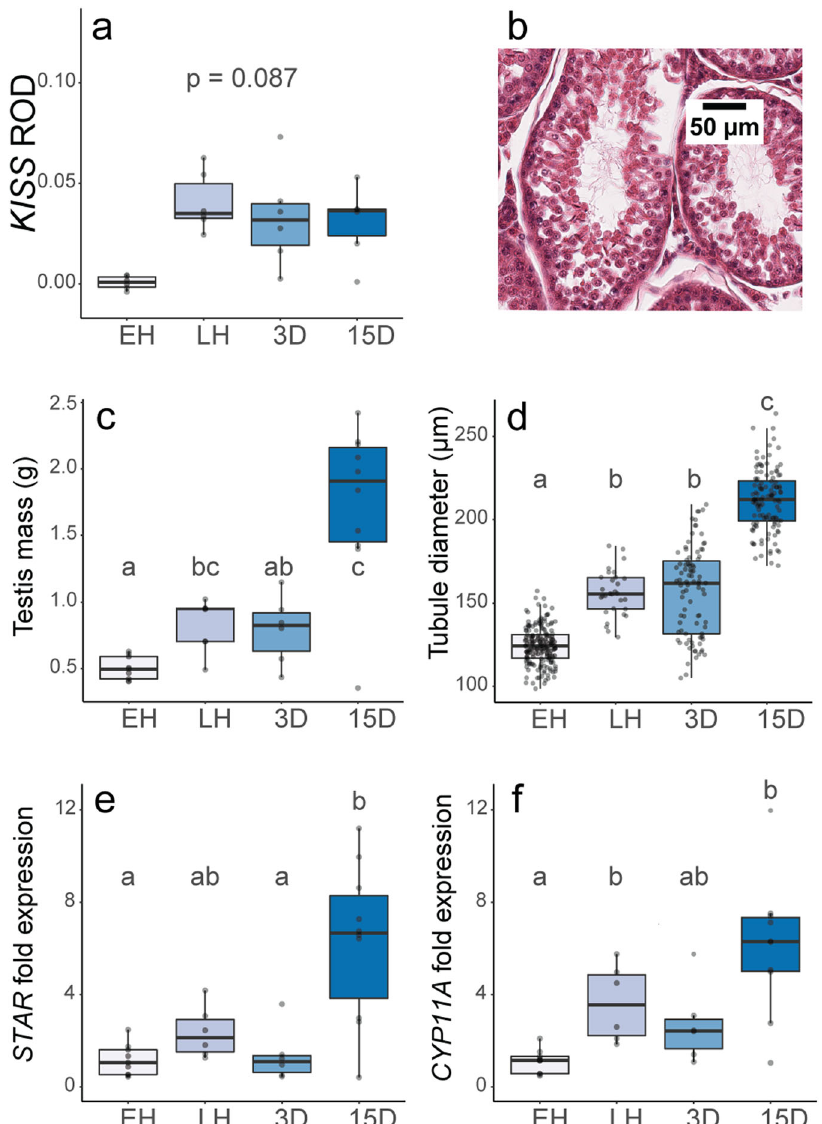
Fig. 5 Activation of reproductive axis during hibernation in male arctic ground squirrels. a Kisspeptin expression in the arcuate nucleus as quanti fi ed by in-situ hybridization (ROD = relative optical density). b Seminiferous tubule of 15D post-hibernation male arctic ground squirrel illustrating extrusion of cytosol from spermatids. c Mass of frozen testes and d diameter of seminiferous tubules in preserved testicular tissue from male arctic ground squirrels. Changes in the expression of steroidogenic genes e STAR and f CYP11A relative to early hibernation time points as quanti fi ed by qPCR of testicular tissue from male arctic ground squirrels. In all graphs, colored shading of boxplots represents distinct sampling groups, lower-case letters indicate signi fi cantly different comparisons from data analyzed with a linear mixed effects model ( p < 0.05), The center line in the box plot represents the median, box boundaries represent the 25th and 75th percentiles, and error bars of boxplots represent the 25th and 75th percentiles ± 1.5 times the interquartile range. For sample sizes, see “ Methods ” . See also Supplementary Figs. S1 and